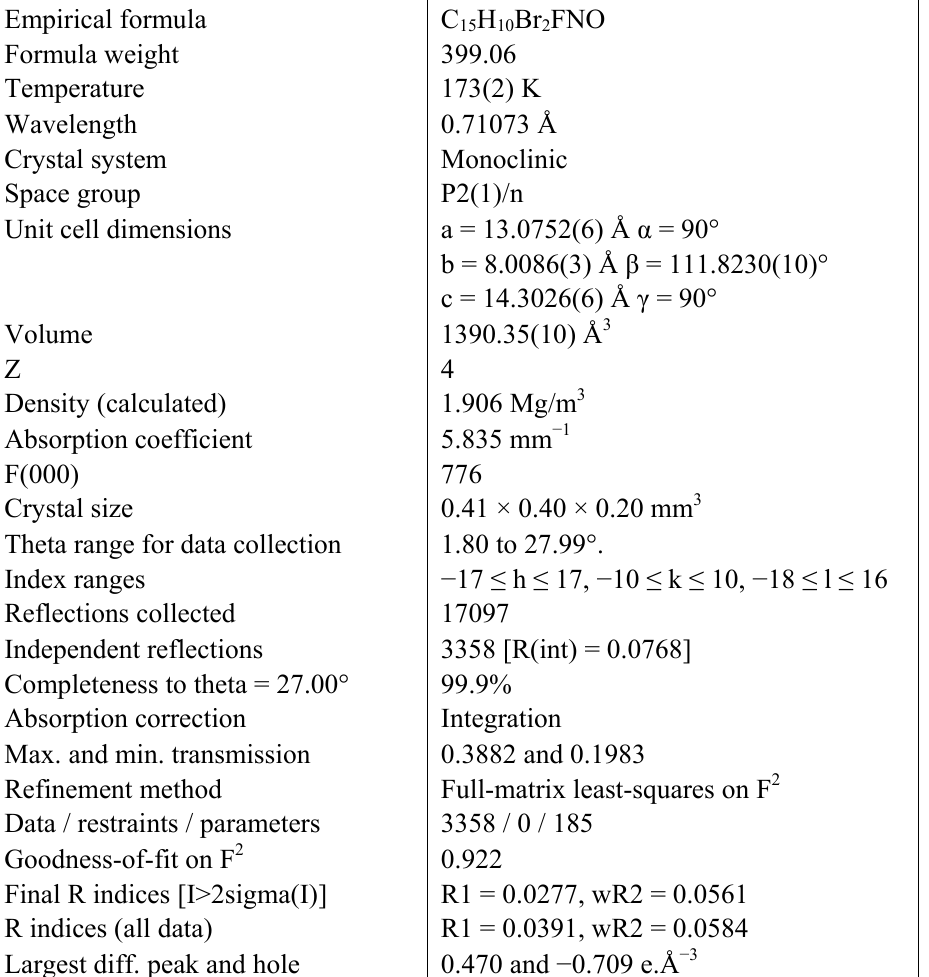
Table 1. Crystal data and structure refinement for compound 3b